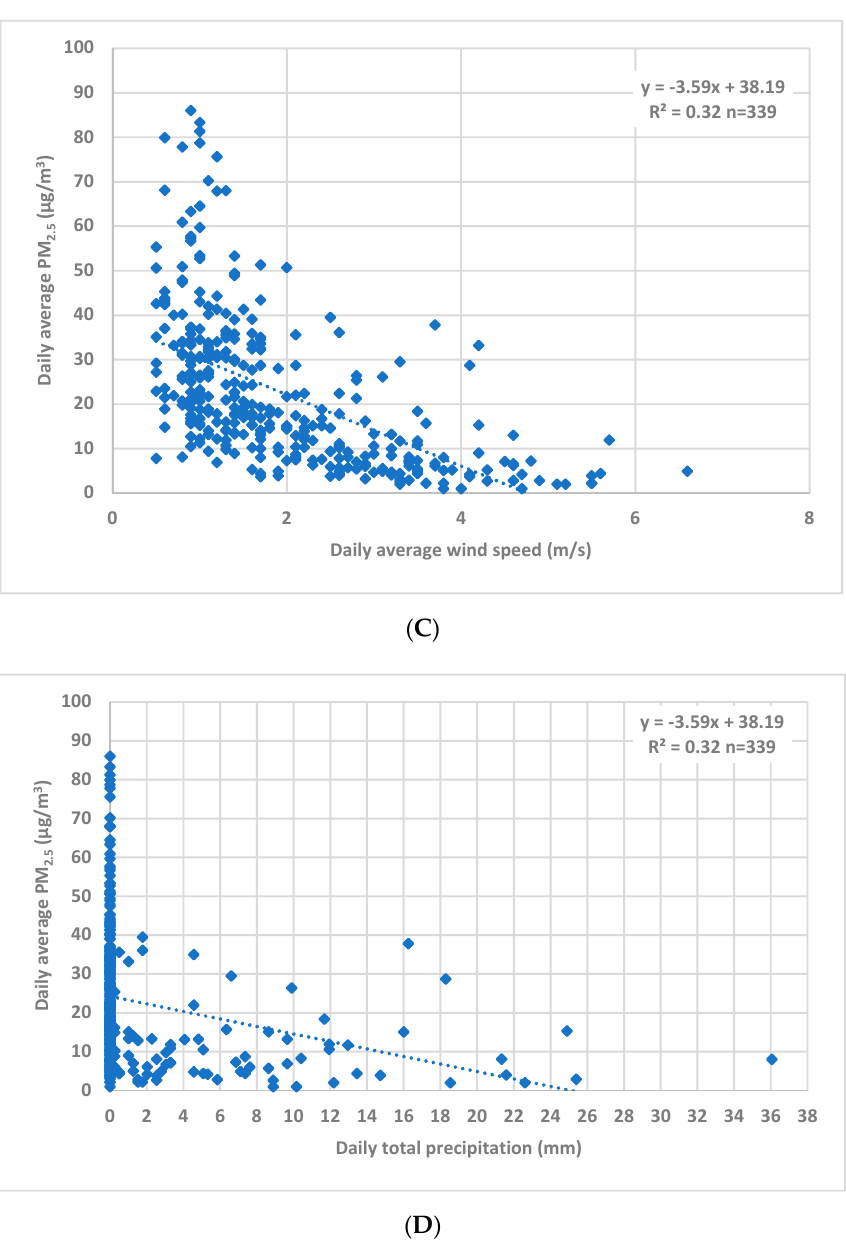
Figure 8. Daily average PM 2.5 at Garland versus ( A ) daily average Trimmer–Garland potential temperature; ( B ) daily average Garland temperature; ( C ) daily average wind speed at Fresno airport; ( D ) daily total precipitation at Fresno airport.